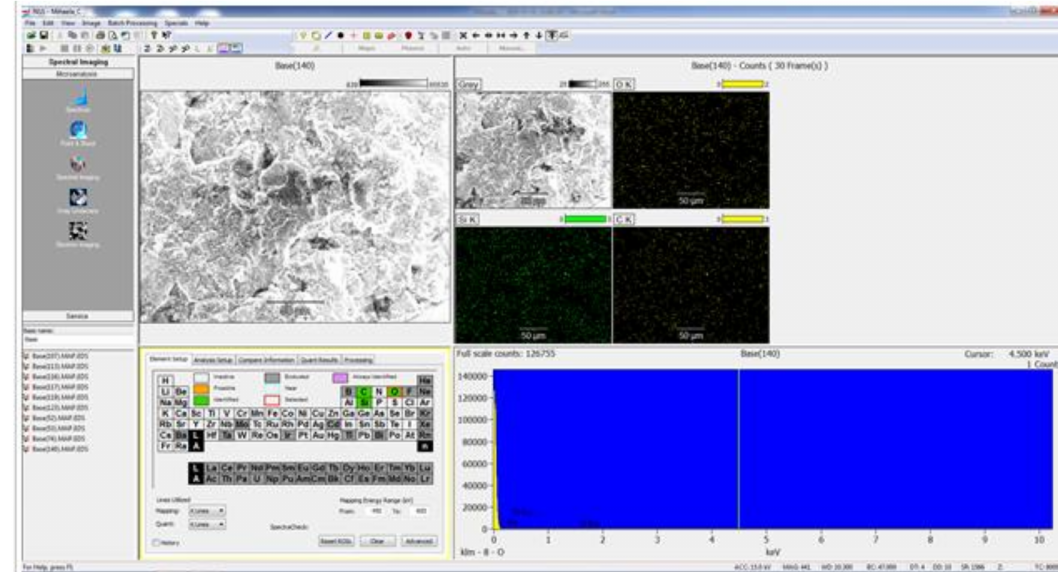
Figure 2. Software used to perform EDX analysis.